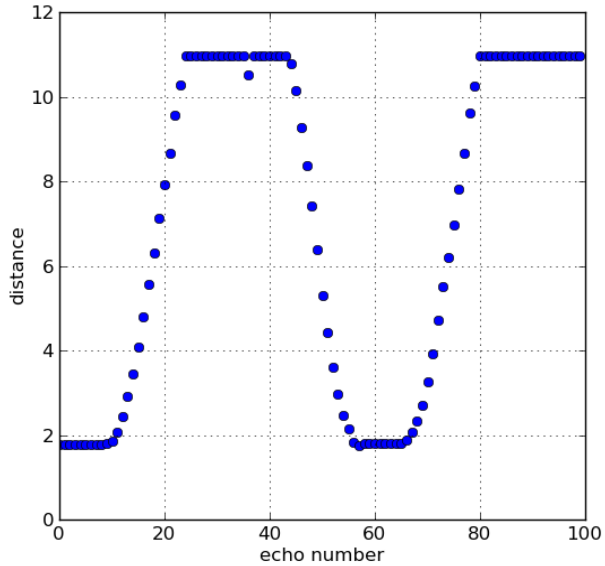
Figure 6. Measurements made with the sensor placed in a car moving in front of a parked